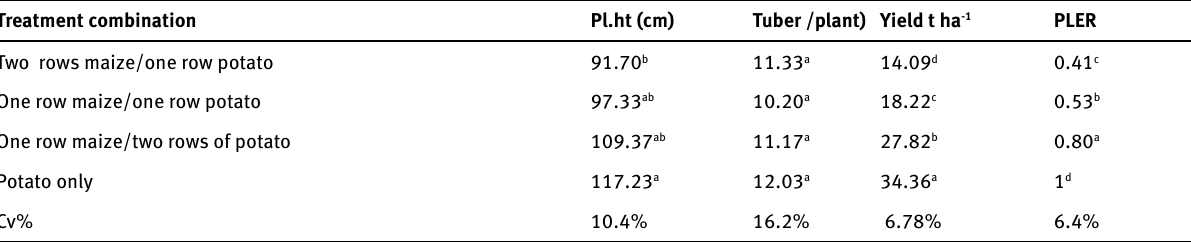
Table 2: Yield and yield components of potato with different planting patterns (Hawzen 2012) Treatment combination